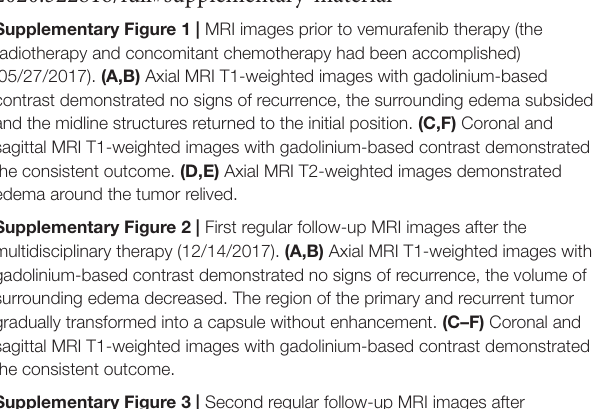
Supplementary Figure 1 | MRI images prior to vemurafenib therapy (the radiotherapy and concomitant chemotherapy had been accomplished) (05/27/2017). (A,B) Axial MRI T1-weighted images with gadolinium-based contrast demonstrated no signs of recurrence, the surrounding edema subsided and the midline structures returned to the initial position. (C,F) Coronal and sagittal MRI T1-weighted images with gadolinium-based contrast demonstrated the consistent outcome. (D,E) Axial MRI T2-weighted images demonstrated edema around the tumor relived. Supplementary Figure 2 | First regular follow-up MRI images after the multidisciplinary therapy (12/14/2017). (A,B) Axial MRI T1-weighted images with gadolinium-based contrast demonstrated no signs of recurrence, the volume of surrounding edema decreased. The region of the primary and recurrent tumor gradually transformed into a capsule without enhancement. (C–F) Coronal and sagittal MRI T1-weighted images with gadolinium-based contrast demonstrated the consistent outcome. Supplementary Figure 3 | Second regular follow-up MRI images after multidisciplinary therapy (03/20/2018). (A,B) Axial MRI T1-weighted images with gadolinium-based contrast demonstrated no signs of recurrence, the volume of surrounding edema further decreased. The region of the primary and recurrent tumor gradually transformed into a capsule without enhancement. (C–F) Coronal and sagittal MRI T1-weighted images with gadolinium-based contrast demonstrated the consistent outcome. Supplementary Figure 4 | Third regular follow-up MRI images of the latest follow-up after multidisciplinary therapy (06/09/2018). (A,B) Axial MRI T1-weighted images with gadolinium-based contrast demonstrated similar features with the second former follow-up results. (C–F) Coronal and sagittal MRI T1-weighted images with gadolinium-based contrast demonstrated the consistent